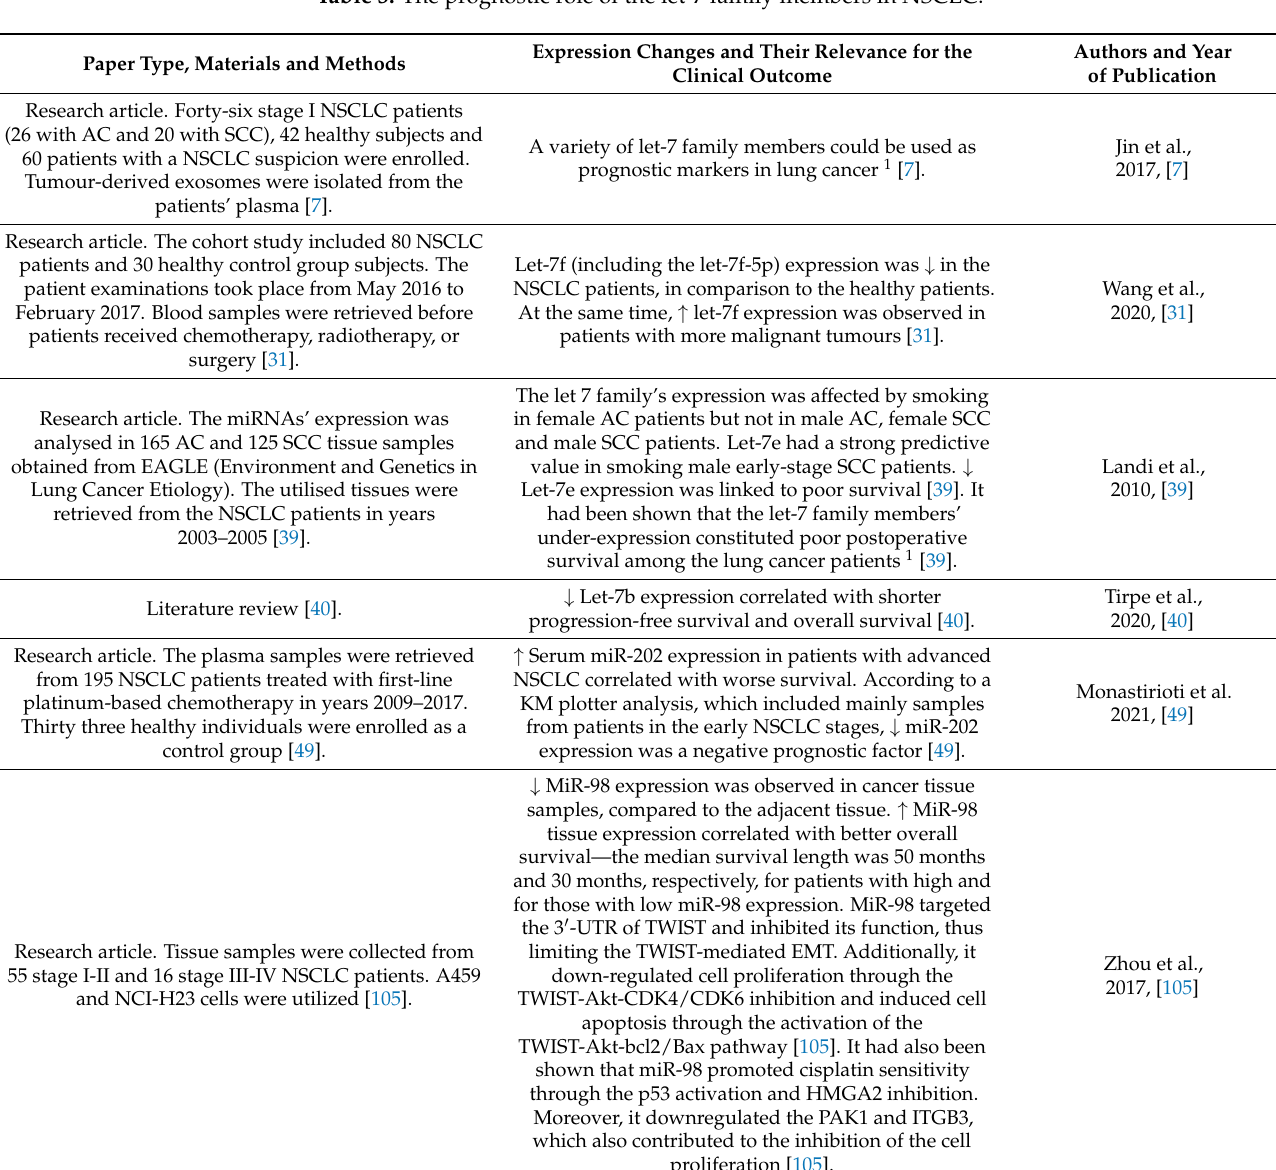
Table 3. The prognostic role of the let-7 family members in